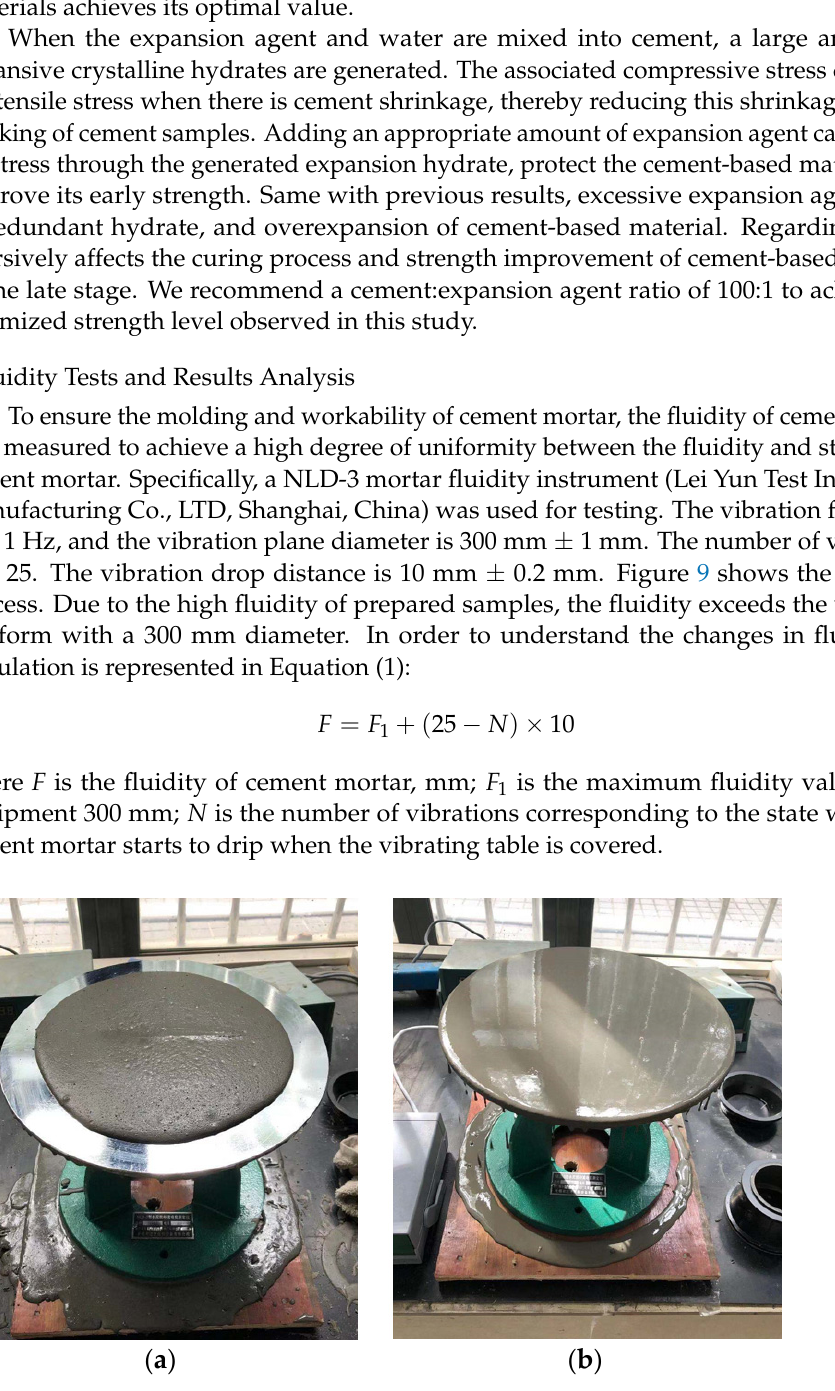
Figure 9. Fluidity test ( a ): low fluidity status; ( b ) high fluidity status.